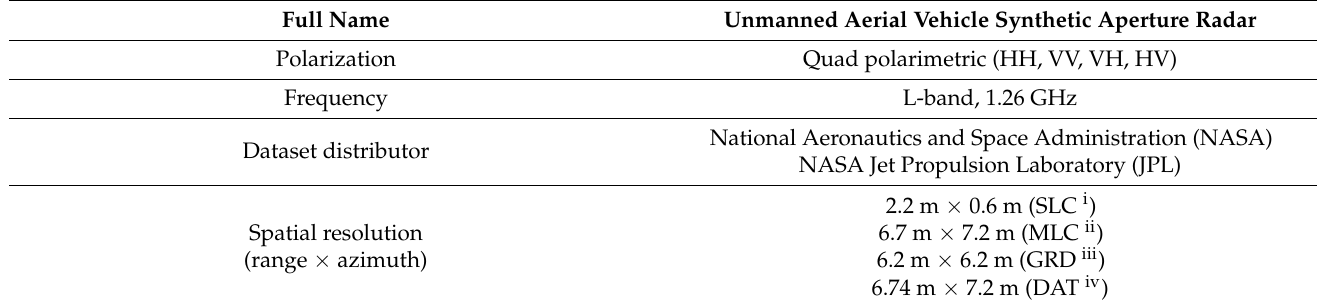
Figure 1. The Soil Moisture Active Passive Experiment (SMAPVEX12) study area is located in southwestern Manitoba (Canada). The locations of corn, soybean, and wheat fields sampled during SMAPVEX12 are indicated. Table 1. Airborne UAVSAR sensor